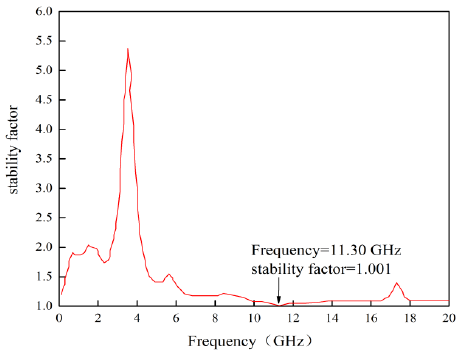
Figure 4. Simulated curve of stability factor.